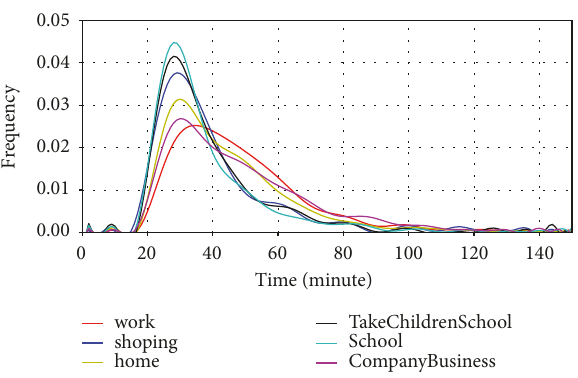
Figure 13: Comparison of bus travel time with different purposes.